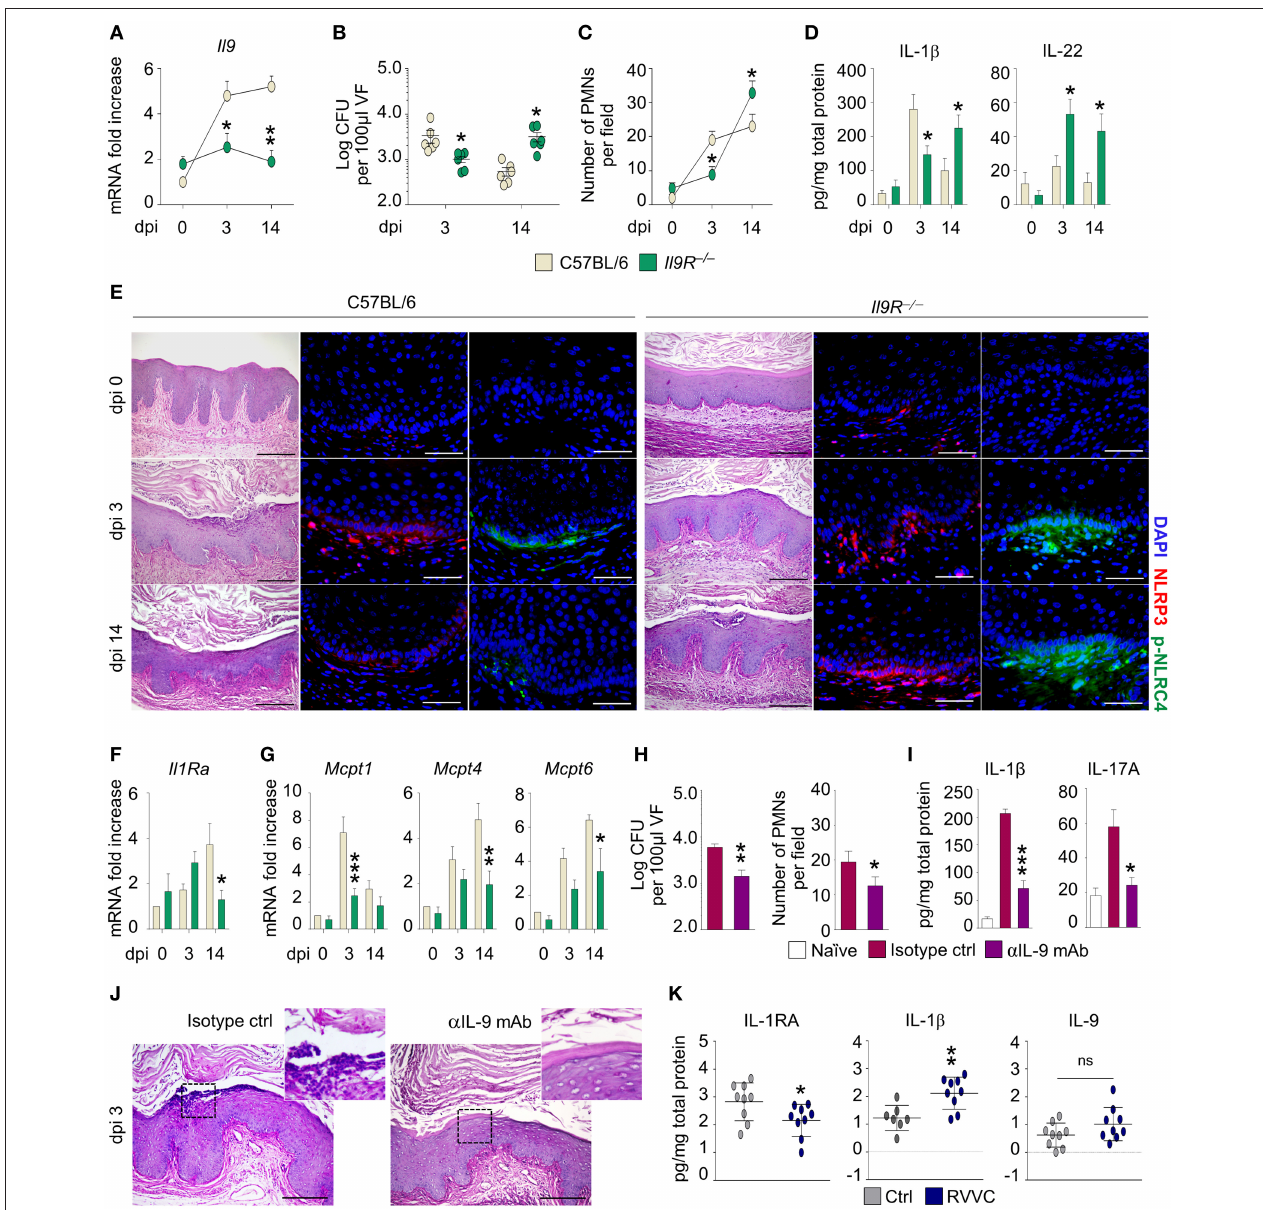
FIGURE 1 | C57BL/6 and Il9R − / − mice were intravaginally infected with Candida blastoconidia. (A) Il9 expression (RT-PCR) in vaginal cells; (B) fungal burden (Log CFU/100 µ l VF); (C) PMN recruitment in VF; (D) cytokine levels (ELISA) in VF; (E) vaginal pathology (periodic acid-Shiff-staining) and immunofluorescence staining with anti-NLRP3 or anti-pNLRC4 antibodies; (F) Il1Ra expression and (G) MC proteases gene expression (RT-PCR) in vaginal cells. C57BL/6 mice were infected and treated intraperitoneally with mAb neutralizing IL-9 or isotype control and assessed for (H) fungal burden (Log CFU/100 µ l VF) and PMN recruitment in VF; (I) IL-1 β and IL-17A production (ELISA) in VF and (J) vaginal pathology (periodic acid-Shiff-staining). (K) Cytokine production in the VF of healthy women (Ctrl) or patients with recurrent vulvovaginal candidiasis (RVVC). Data represent pooled results (mean ± SEM) or representative images from three experiments. * p < 0.05, ** p < 0.01, *** p < 0.001, knockout vs. C57BL/6 mice and treated vs. untreated mice. Unpaired t -test, one- or two-way ANOVA, Bonferroni post-hoc test. dpi, days post-infection; VF, vaginal fluid; PMNs, polymorphonuclear cells; ns, not significant.